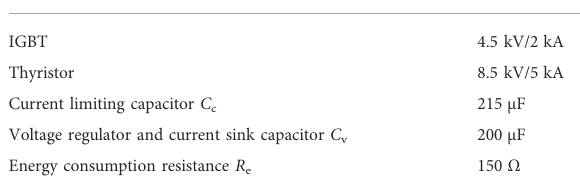
TABLE 2 DC circuit breaker parameters.